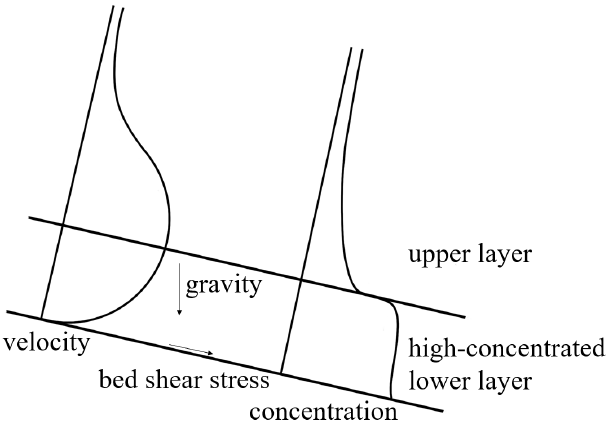
Figure 1. Sketch of the